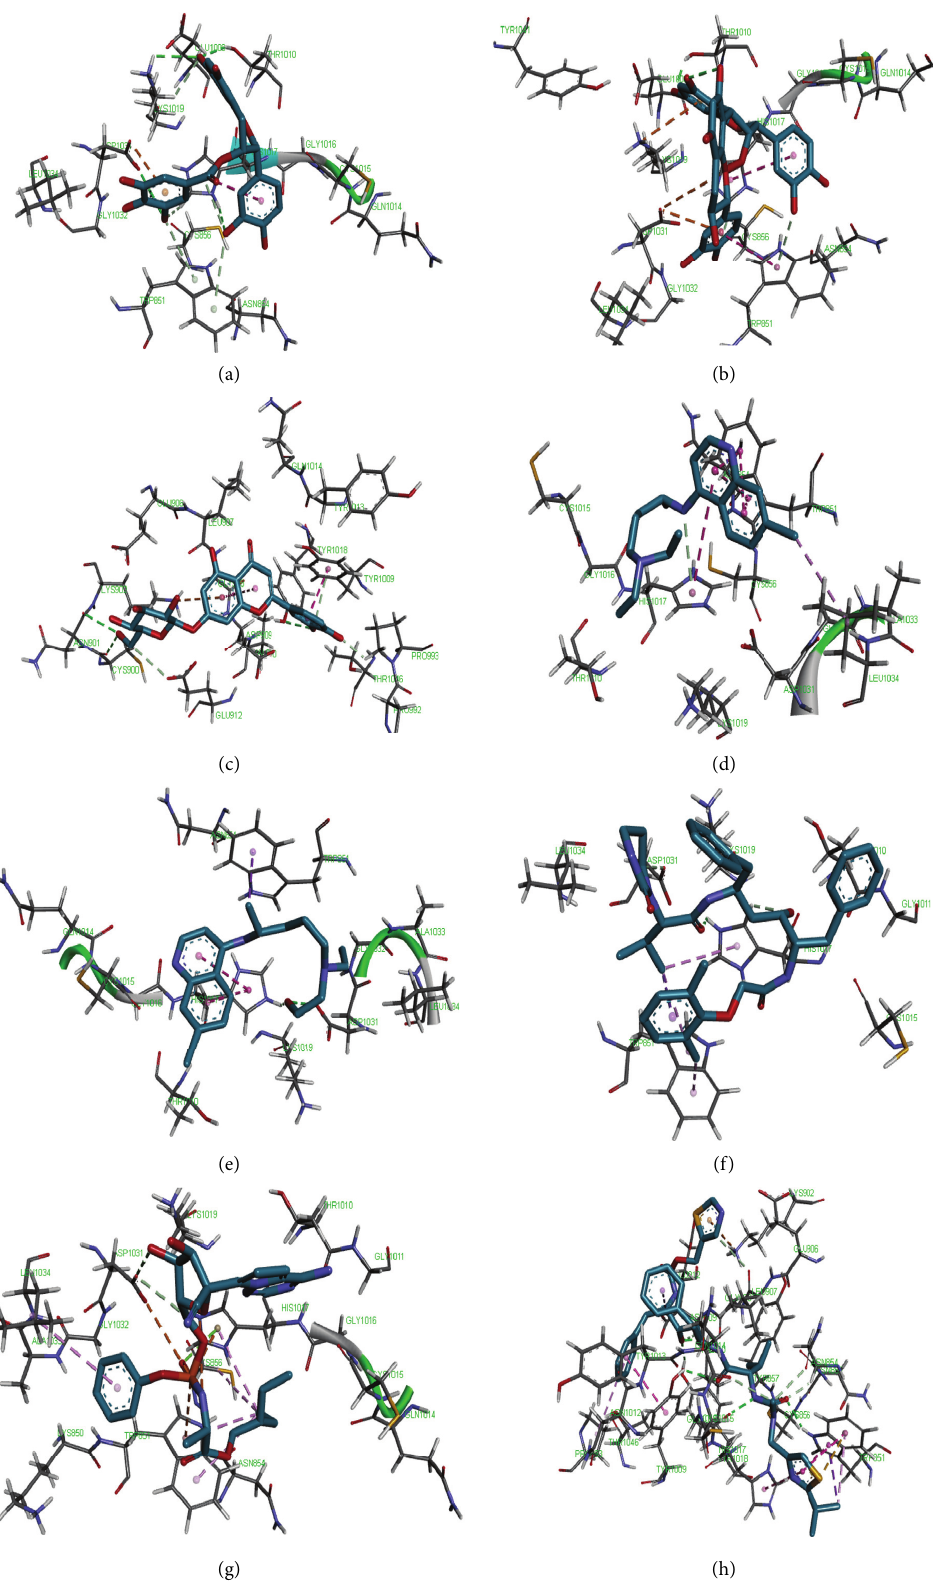
Figure 2: 3D representation of (a) 3-galloylcatechin, (b) proanthocyanidin B1, (c) luteolin 7-galactoside, (d) chloroquine, (e) hydrox- ychloroquine, (f) lopinavir, (g) remdesivir, and (h) ritonavir in the binding pocket of